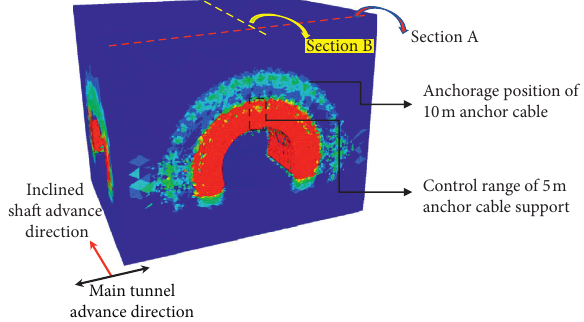
Figure 23: Compressive stress distribution contour with the pretension